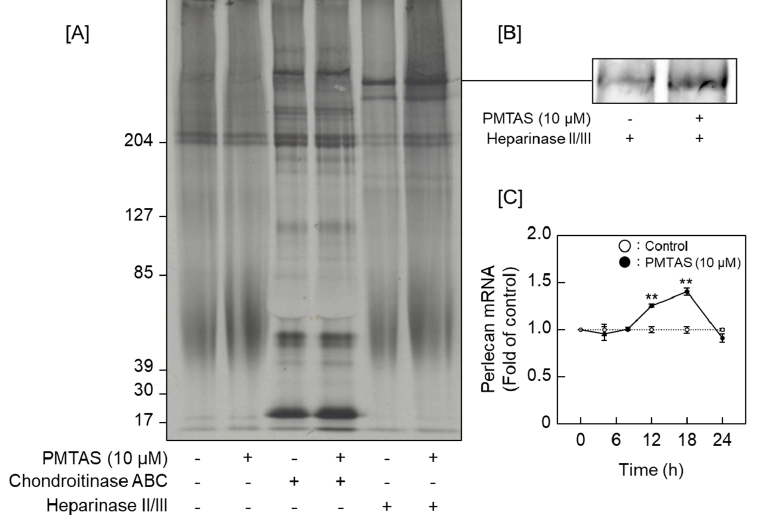
Figure 8. Expression levels of perlecan core protein that accumulated in the conditioned medium and perlecan mRNA in vascular endothelial cells after treatment with PMTAS: [ A ] [ 35 S]Amino acids-labeled proteoglycan core proteins analysis via autoradiography, vascular endothelial cells were treated with PMTAS (10 µM) for 48 h; ( B ) perlecan core protein expression detection via Western blotting, vascular endothelial cells were treated with PMTAS (10 µM) for 48 h; ( C ) perlecan core protein mRNA expression,values are represented as means ± S.E. of four samples, ** p < 0.01 vs. corresponding control.